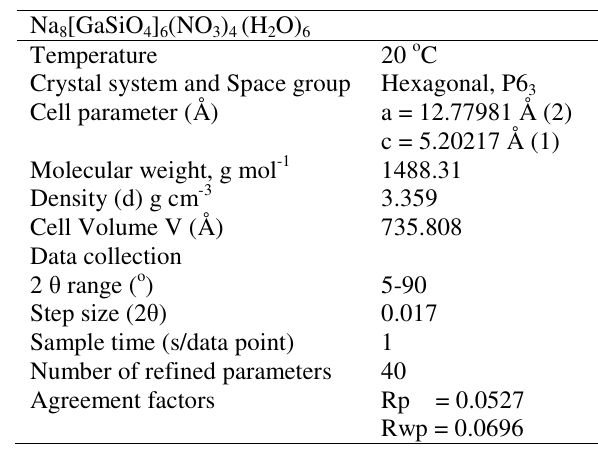
Table 1. Crystallographic data and experimental conditions for the structure refinement of gallosilicate nitrate